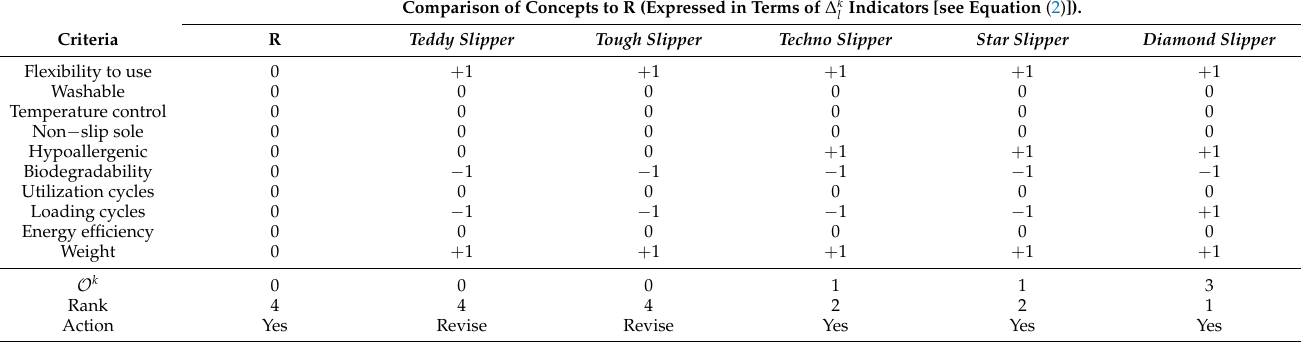
Table 15. Results of concept